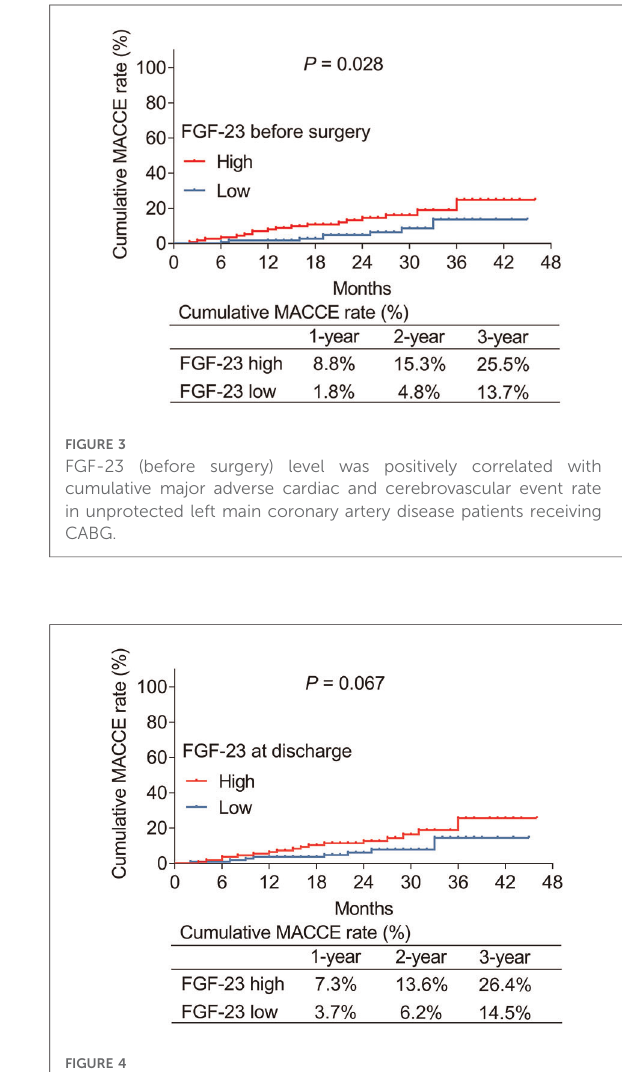
surgery) high group was 8.8%, 15.3%, and 25.5%, respectively; while 1.8%, 4.8%, and 13.7% in FGF-23 (before surgery) low group, respectively.